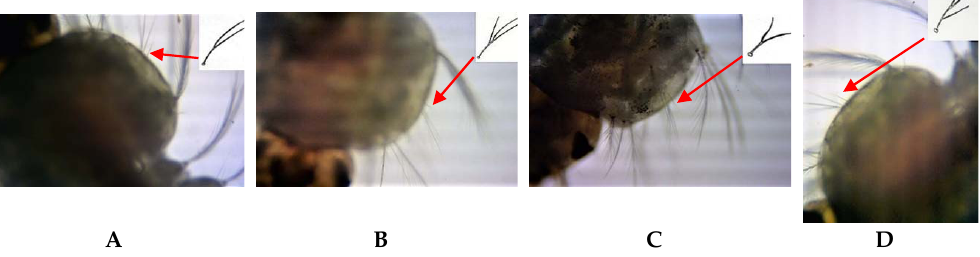
Figure 2. Mesothoracic seta 4 of sibling species A , B , C , and D ( × 200 × 2). Position of the setae is shown with an arrow. The shape of the setae is schematically shown [6] in the top-right corner of each